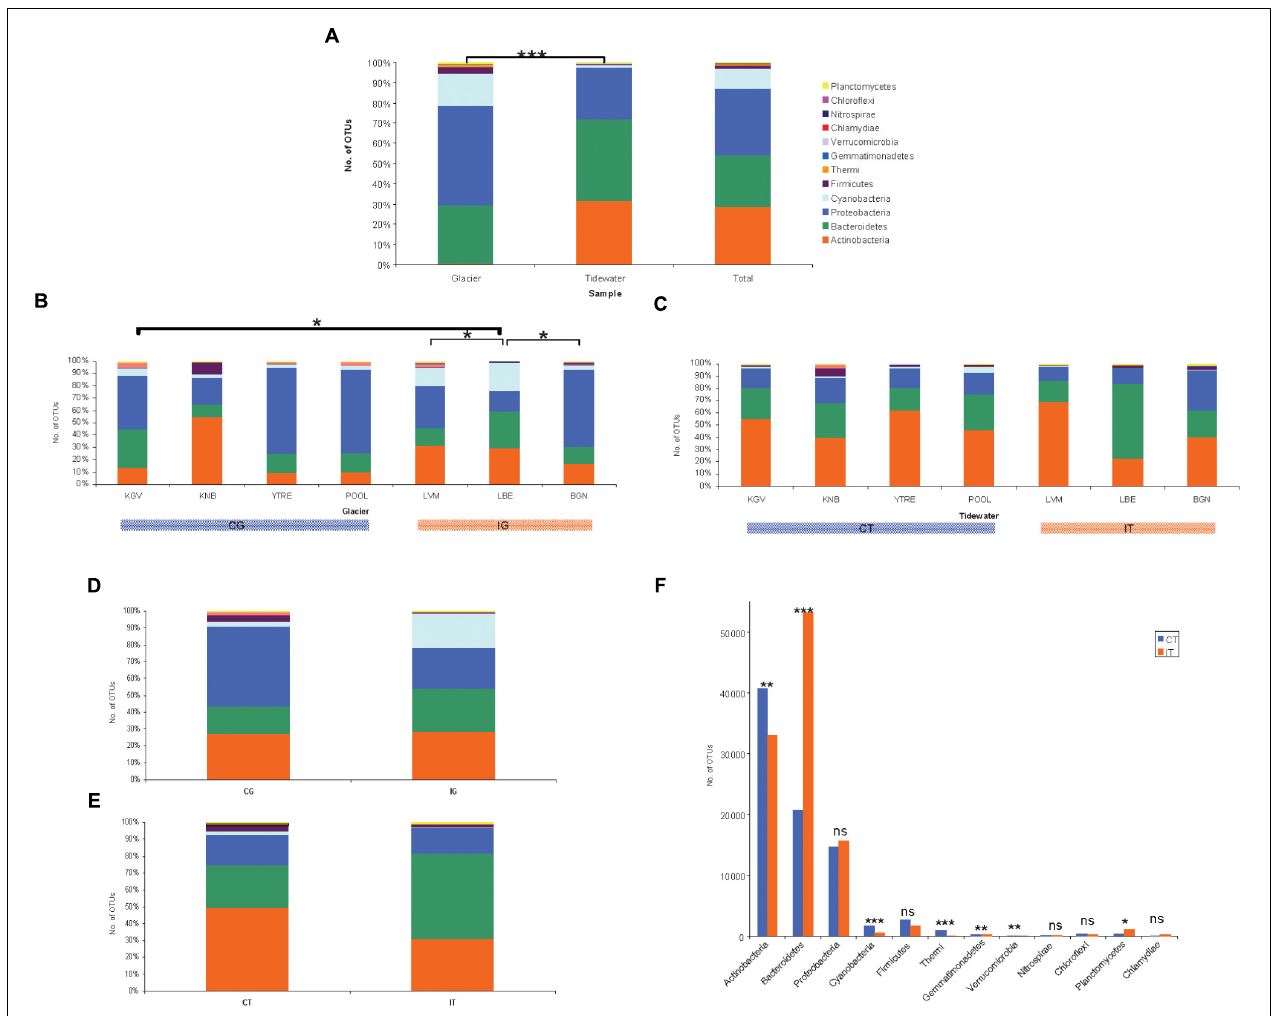
FIGURE 3 | Microbial communities composition. Number of counts aggregates at OTU level of three sampling replicates from glacial ice and tidewater samples. The values represent means of three replicates from each glacier. (A) Comparison of bacterial abundance between samples from glacier ice and tidewater. Significant differences were observed by Student’s t -test for Cyanobacteria, Proteobacteria, and Actinobacteria ( ∗∗∗ p < 0.0001). (B) Comparison of bacterial abundance among samples from glaciers was analyzed by ANOVA and Newman–Keuls Multiple Comparison Test. The number of OTUs was significantly different to between LBE and BGN, LVM and KGV ( ∗ p < 0.05). (C) Comparison of bacterial abundance among seawater samples by ANOVA demonstrated significant differences ( ∗∗∗ p < 0.0001). The Newman–Keuls Multiple Comparison Test revealed that the number of OTUs in LBE was significantly different to the rest seawater samples in almost all pairs ( ∗ p < 0.001). (D) Comparison of bacterial total abundance between samples from coastal glaciers (CG) and inland glaciers (IG). Differences determined by Student’s t -test were not significant. (E) Comparison of bacterial total abundance between samples from the tidewater area closest to a